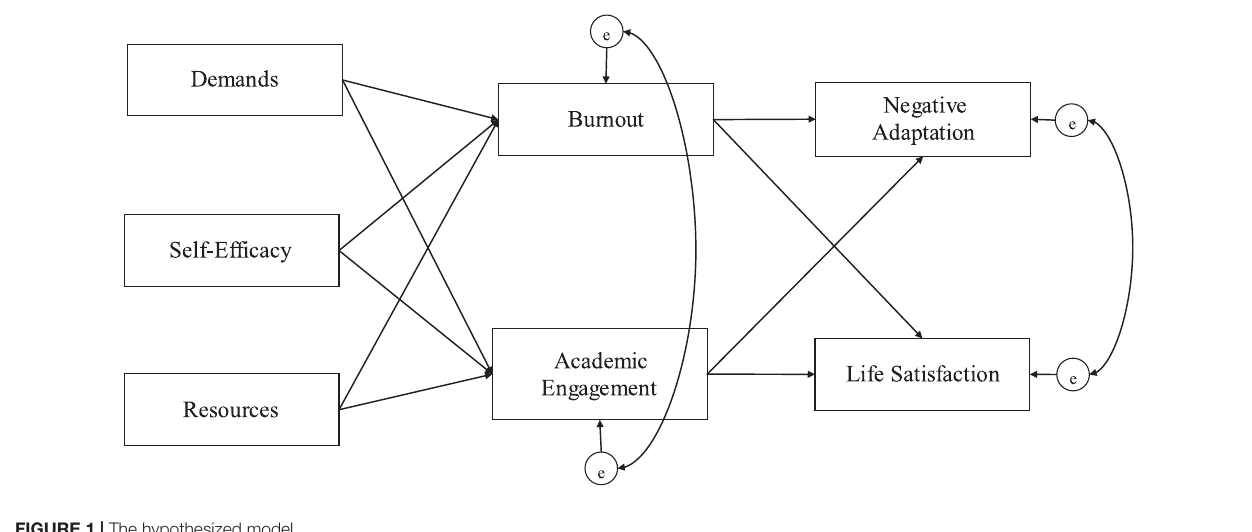
FIGURE 1 | The hypothesized model.